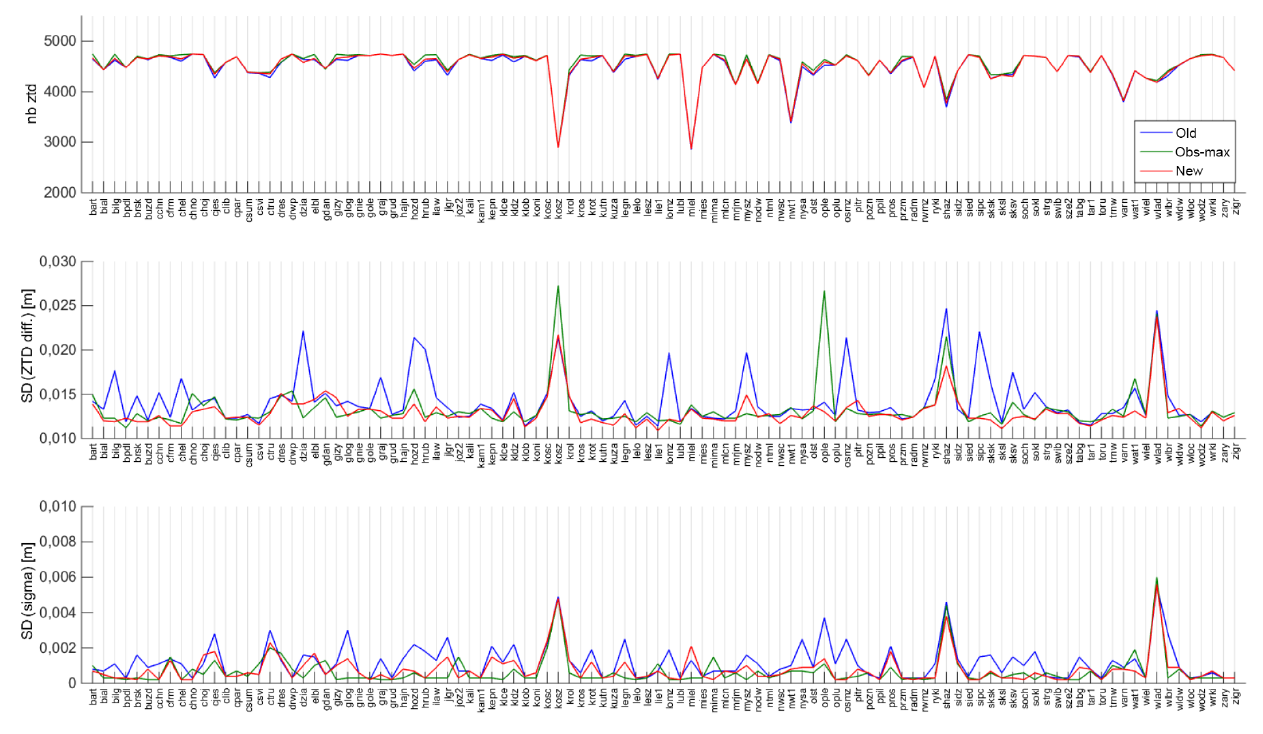
Figure 9. Distribution of standard deviations of ZTD differences and formal error of ZTD for the 104 common ASG-EUPOS stations: the old solution is the blue line, obs-max is the green line, and the new solution is the red line. Table 3. Number of processed observations with the two processing variants (obs-max and new), on day 170, before and after residual screening carried out automatically by Bernese